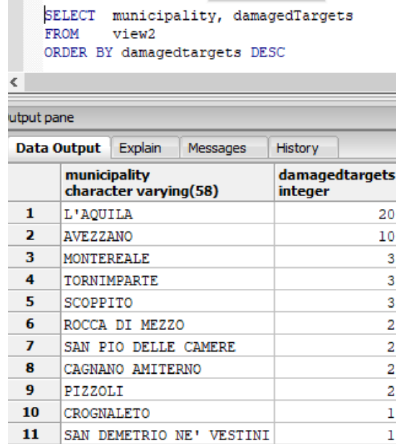
Figure 19. The ranking of the top 11 municipalities hit by the earthquake.